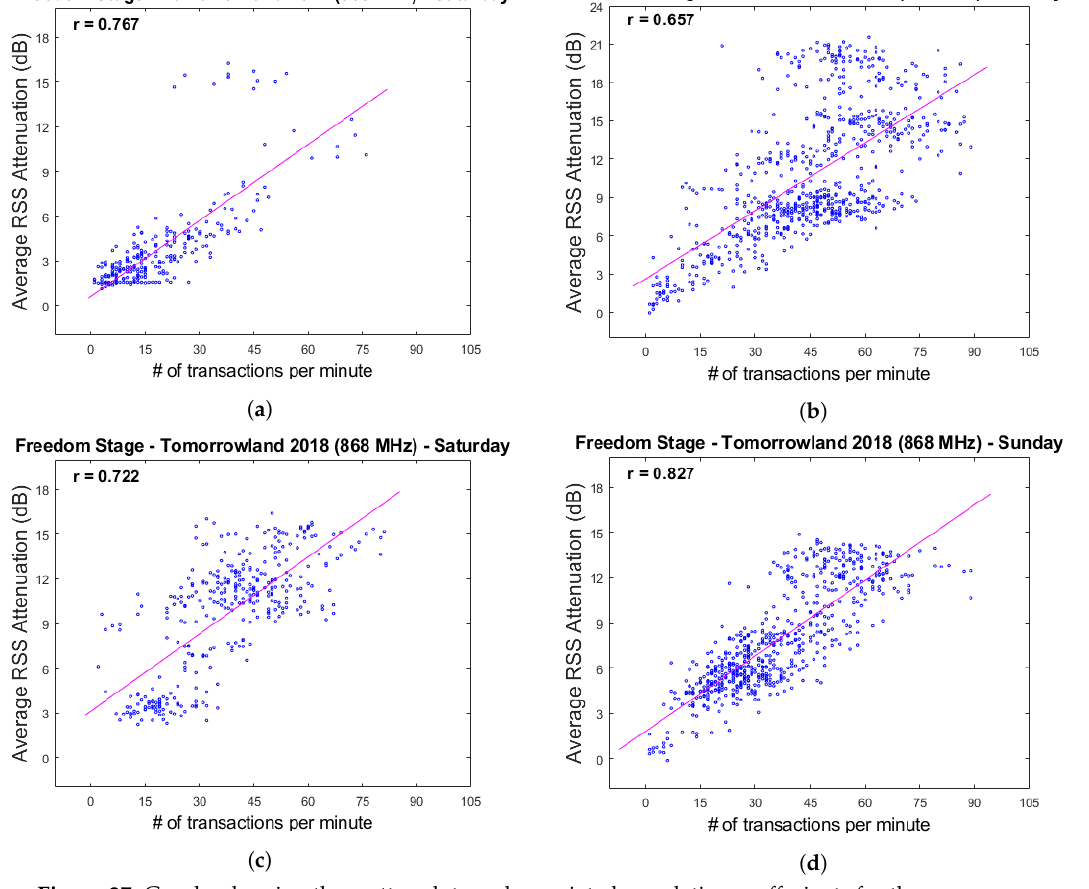
Figure 27. Graphs showing the scatter plots and associated correlation coeffecients for the average rss attenuation and the number of cashless transactions per minute. Plots ( a , b ) are based on data collected on Saturday 29 July 2017 and Sunday 30 July 2017. Plots ( c , d ) are based on data collected on Saturday 28 July 2018 and Sunday 29 July